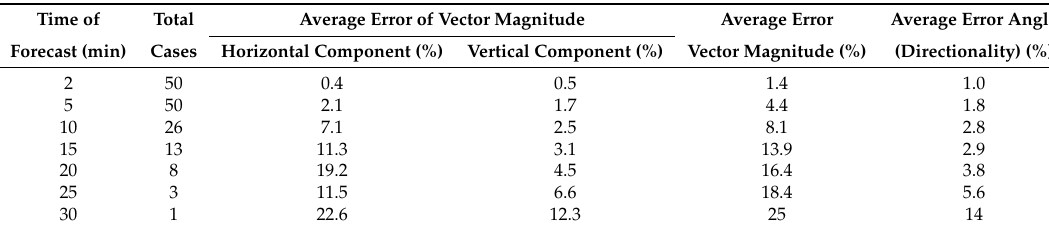
Table 3. Results tracking cloud movement for all